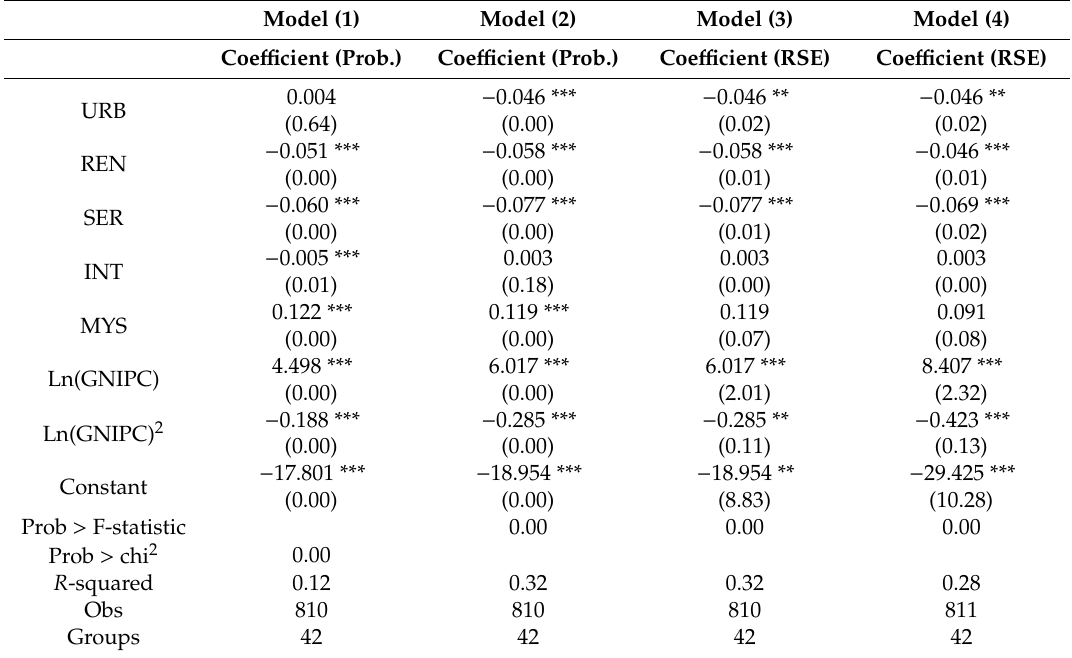
Figure 3. Scatter plot of EF and gross national income per capita ( GNIPC) of all sample countries. In Models (5) and (6), the estimated coefficients and significant extents of URB, REN, SER, MYS, and Ln ( GNIPC ) showed small differences. URB, REN, and SER had statistically significant and negative impacts on EF. Ln ( GNIPC ) had statistically significant and positive impacts on EF. MYS was statistically insignificant. The fact that INT was statistically significant in Model (6) and insignificant in Model (5) demonstrates that INT only had significant lagged impacts on EF. Relative to URB, REN, and SER, the lagged impacts of INT were weaker. The variance inflation factor (VIF) values of MYS and INT were 4.69 and 3.22, respectively, which demonstrates that the estimations of MYS and INT were not likely affected by the problems with multicollinearity. Table 9. Estimations of impacts of influencing factors and control variables for the developed